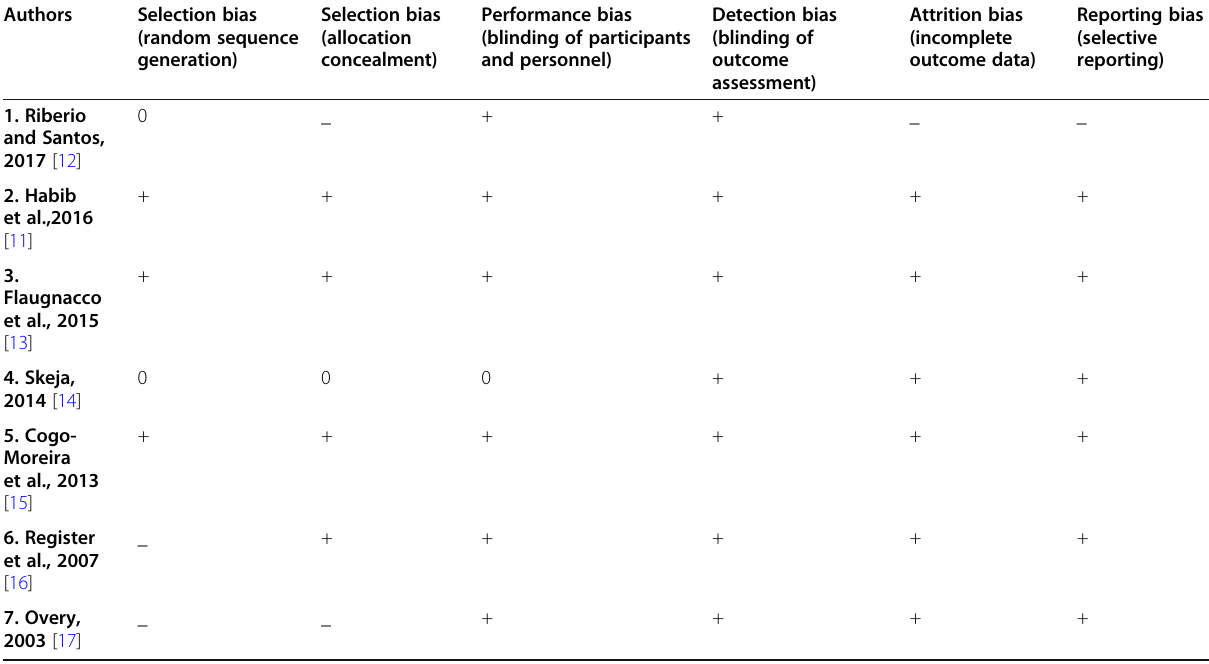
Table 4 Risk of bias